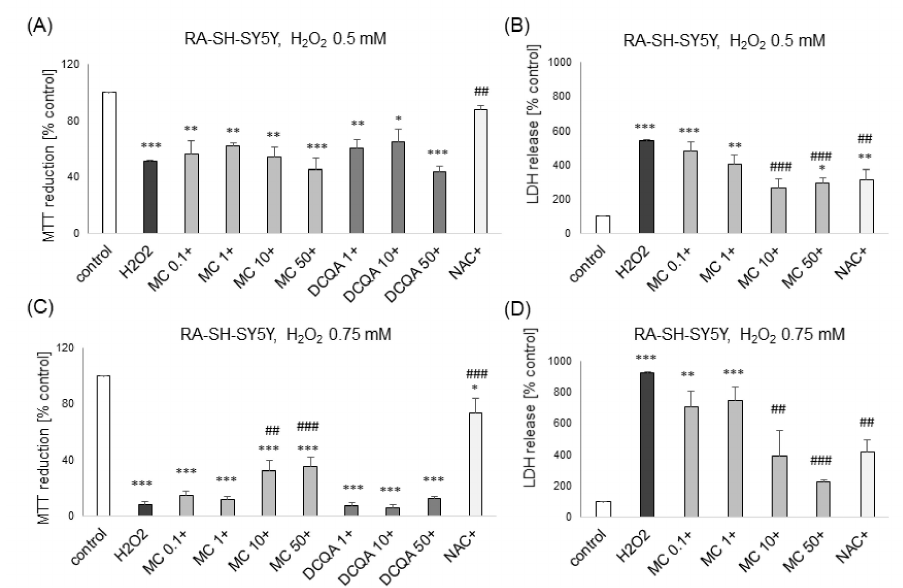
Figure 4. The protective e ff ects of MC against hydrogen peroxide (H 2 O 2 )-evoked RA-SH-SY5Y cell damage. ( A , C ) Cell viability of RA-SH-SY5Y cells pre-treated for 30 min. with MC (0.1–50 µ M) or 3,5-DCQA (1–50 µ M) or co-treated with N-acetylcysteine (NAC, 1 mM) followed by 24 of treatment with 0.5 mM ( A ) or 0.75 mM ( C ) H 2 O 2 measured by MTT reduction assay. ( B , D ) Cell toxicity of RA-SH-SY5Y cells pre-treated for 30 min. with MC (0.1–50 µ M) or co-treated with N-acetylcysteine (NAC, 1 mM) followed by 24 h of treatment with H 2 O 2 with 0.5 mM ( A ) or 0.75 mM ( C ) H 2 O 2 as measured by LDH release assay. Data were normalized to the vehicle-treated cells and are presented as the mean ± SEM. *** p < 0.001, ** p < 0.01, and * p < 0.05 vs. vehicle-treated cells; ### p < 0.001 and ## p < 0.01 vs. H 2 O 2 -treated cells.